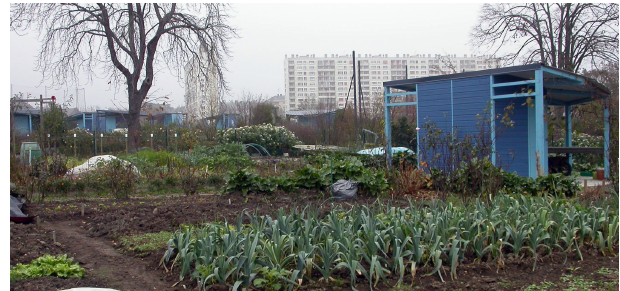
Figure 3. Community gardens in a public park, in the center of Angers (Loire Valley, west